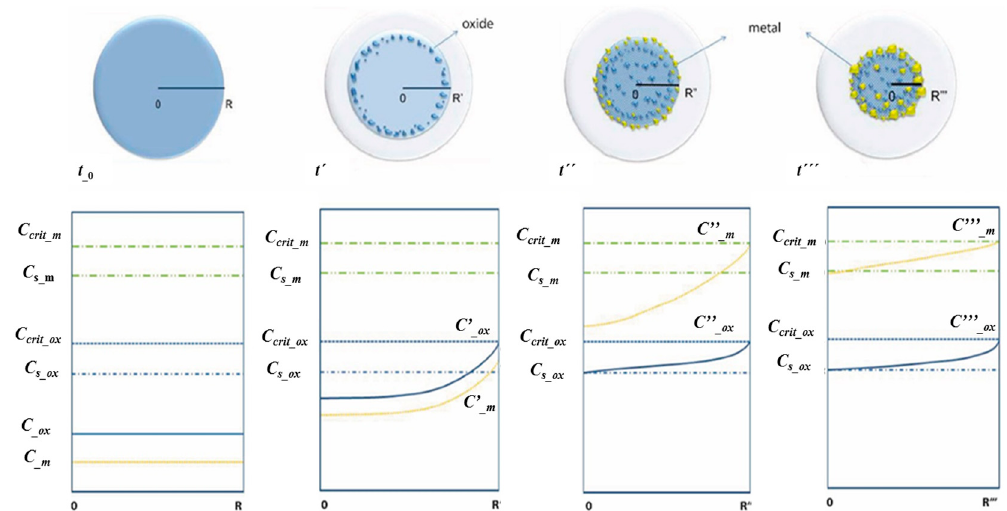
Figure 5. Proposed new model for metal/oxide nanoparticle formation by USP in one-step with the theoretical concentration gradient of oxides and metallic precursors in the droplet during the evaporation/precipitation process steps.